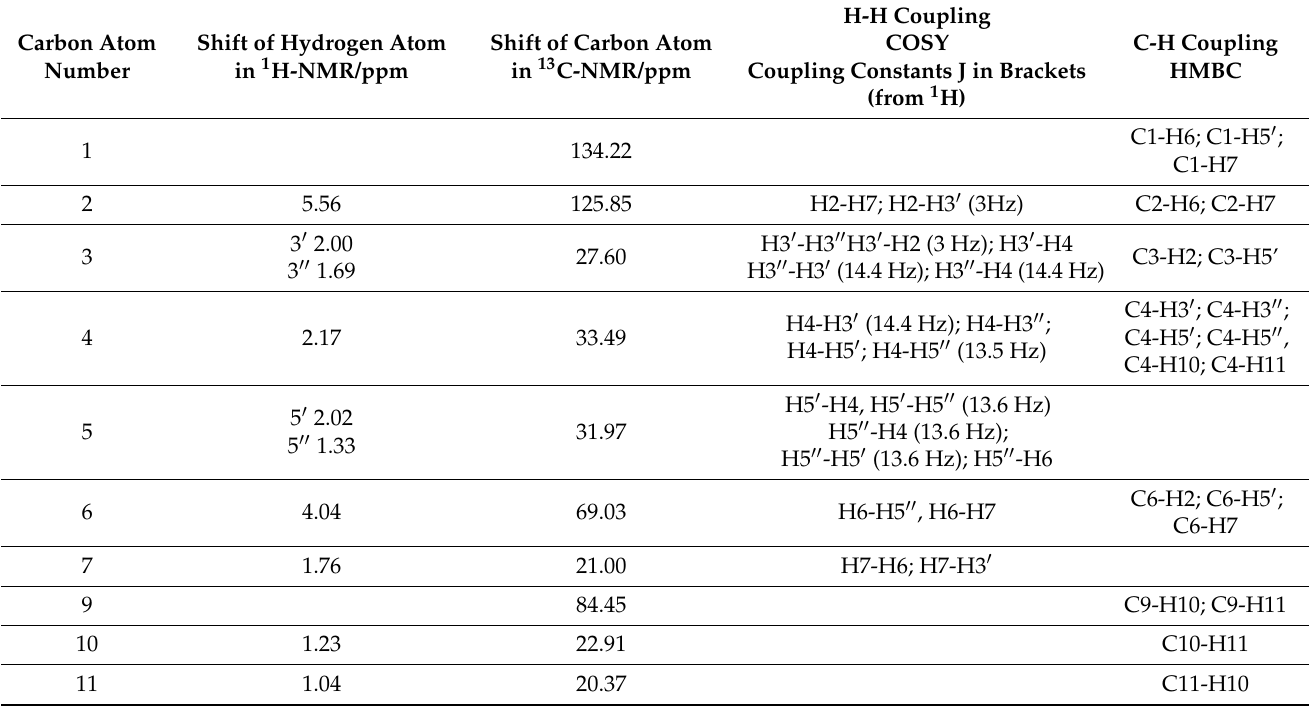
Table 1. Chemical shifts and coupling of NMR